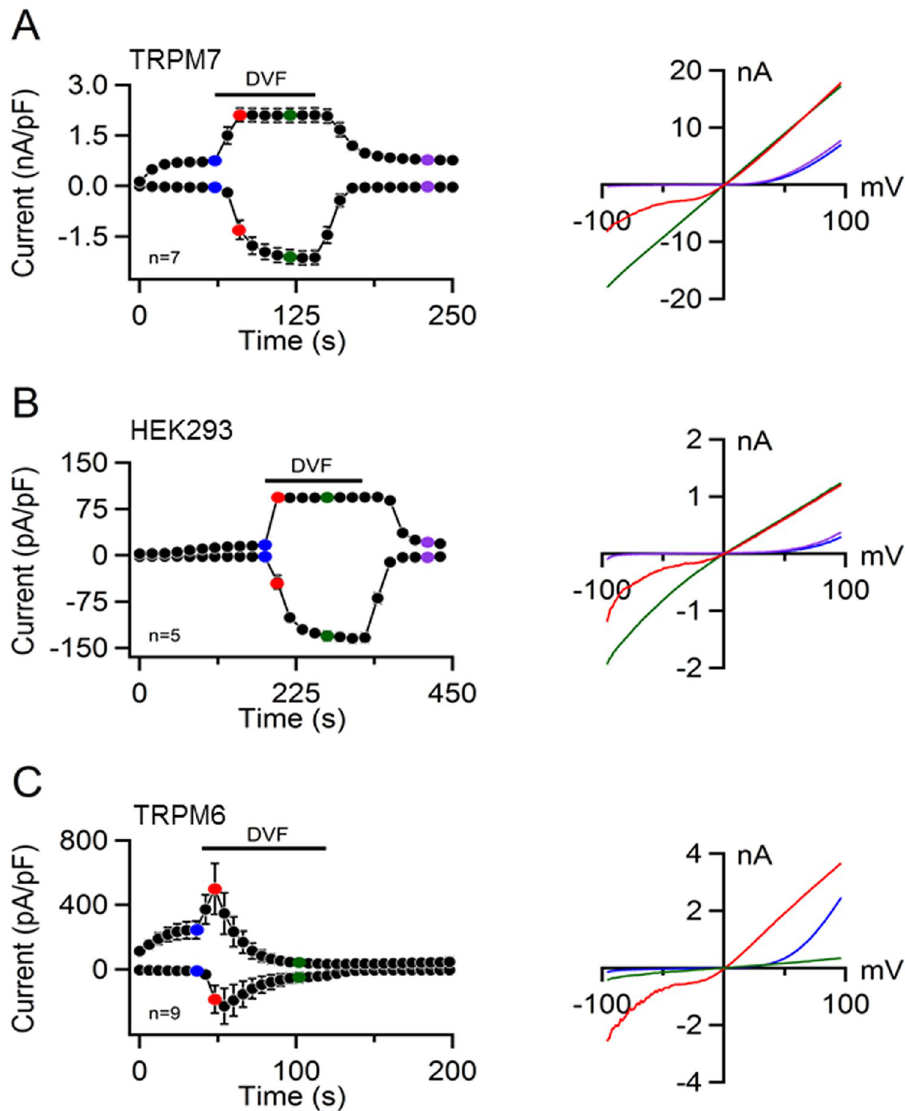
Figure 3. Assessment of mTRPM6 and mTRPM7 currents in a divalent cation-free (DVF) extracellular solution. Whole-cell currents measured in mTRPM7-transfected ( A ), untransfected ( B ) and mTRPM6- transfected HEK 293 cells ( C ). Left panels : Current amplitudes (mean ± SEM) were measured at − 80 and + 80 mV and plotted over time. Currents were induced using the standard [Mg 2 + ] i -free intracellular solution and the standard external solution. When currents were fully activated, cells were perfused with the DVF solution as indicated by the black bars. Right panels : Representative I-V relationships obtained from individual ramps before (blue), during (red and green) and after (violet) DVF application as indicated in the Left panels by coloured data points. n, number of cells